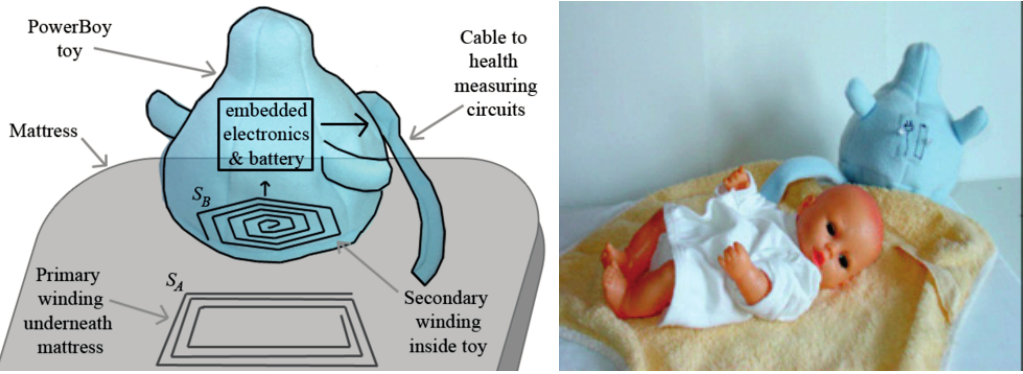
Figure 18. The Powerboy prototype ( left ) and the Powerboy near a baby mannequin ( right ) [40]. Copyright © 2009 IOS